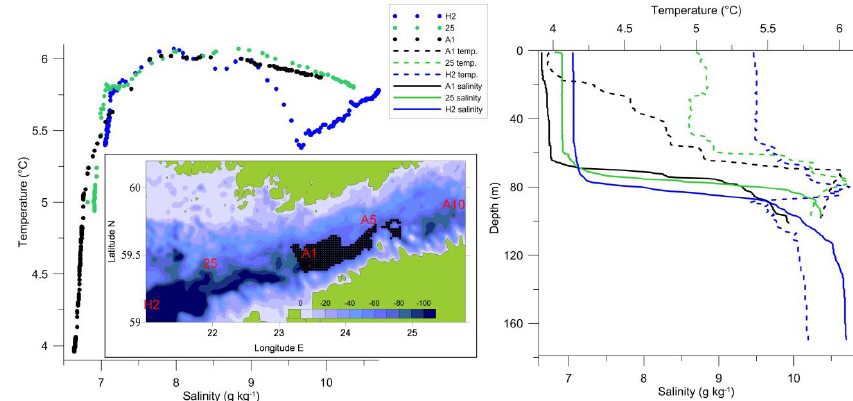
Figure 8. TS-diagrams (dots on left panel), temperature (ºC, dashed lines on right panel) and salinity profiles (g kg –1 , solid lines on right panel) on 24–25 January and hypoxic area (black area on left panel) on 15–16 March. TS-diagrams and profiles at station H2 (blue), 25 (green) and A1 (black). Hypoxic area was estimated only between the western border of the Gulf of Finland and the easternmost station, A10 (Fig. 1). The bottom topography is drawn from the gridded topography in meters (Seifert et al., 2001).